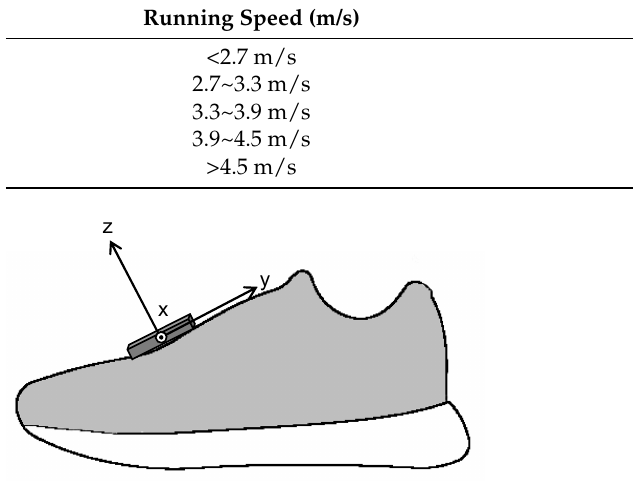
Figure 1. Location of inertial measurement unit and its coordinate system.